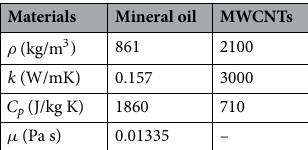
Table 1. Thermal and physical properties of mineral oil and MWCNTs 20